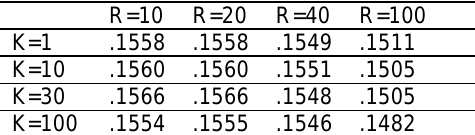
Table 2. Effects of varying R (minimum count) and K (damping constant) on malware